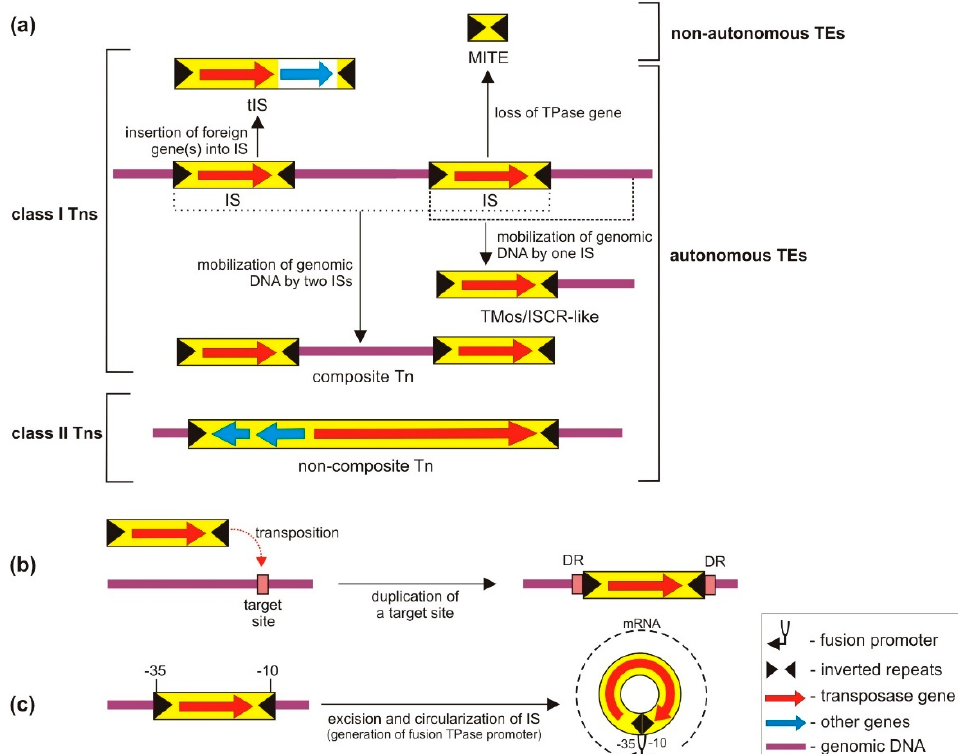
Figure 1. The main structural types and specific properties of bacterial TEs: ( a ) Simplified view of the structural diversity of class I and class II transposons. IS—insertion sequence; tIS—transporter IS; MITE—miniature inverted-repeat transposable element. The class II Tns are represented here by a Tn 3 family element; ( b ) duplication of a target site during transposition and generation of directly repeated sequences (DRs) flanking the inserted TE; ( c ) divided promoter of a TPase gene. After IS circularization, the − 10 and − 35 hexamers form a strong fusion promoter (P) enabling efficient TPase expression.